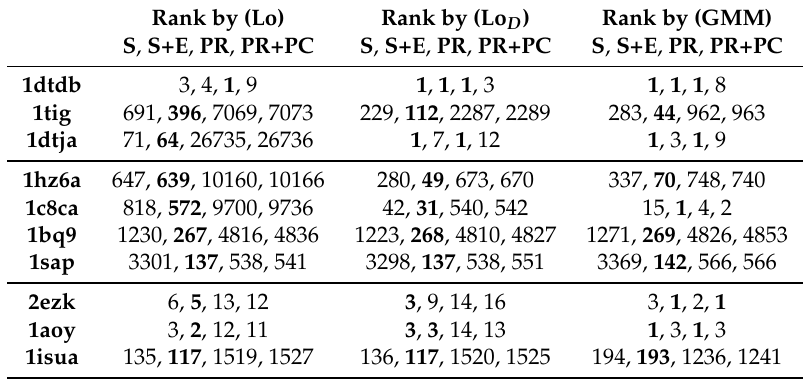
Table 5. Rank (by Size(S), Size and Energy(S+E), Pareto rank(PR), Pareto rank and Pareto count (PR+PC)) of the community with the highest purity among those identified by Louvain (Lo), Louvain Directed (Lo D ) and GMM. Rank by